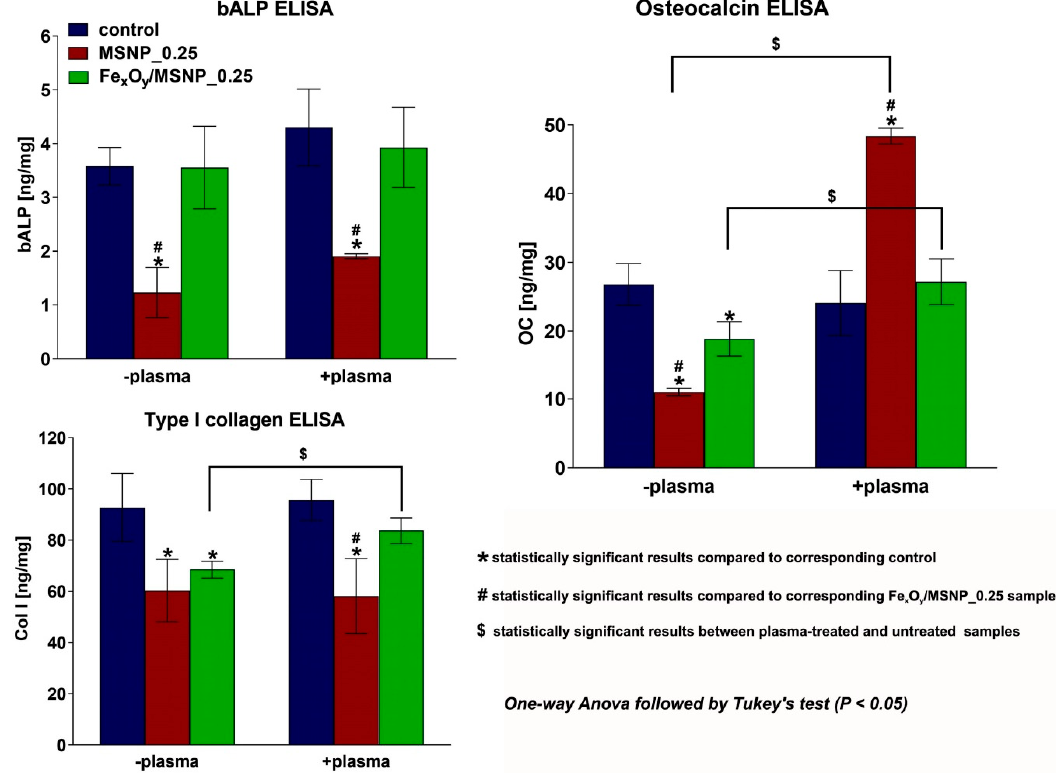
Figure 8. Osteogenic differentiation of ADSCs on the surface of the NPs-loaded scaffolds determined 20 days after nitrogen plasma exposure (16 s in HBSS; cells left in HBSS for 3 h after plasma treatment); control – biomaterial without any NPs; 0.25 – concentration (wt.%) of NPs within the structure of the biomaterial.